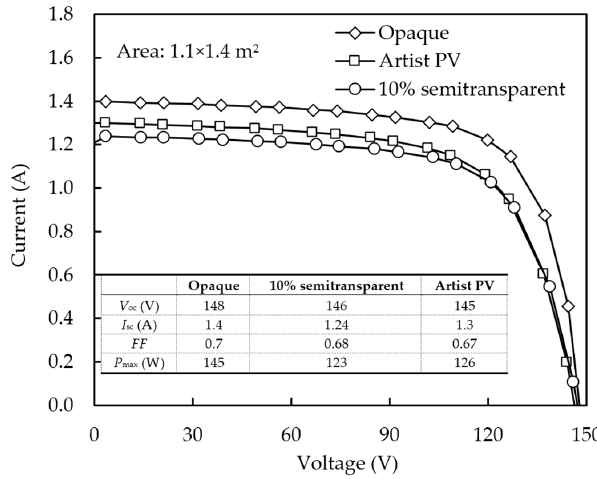
Figure 6. Current-voltage ( I - V ) characteristics of opaque, 10% semi-transparent and artist a-Si/µc PV modules.